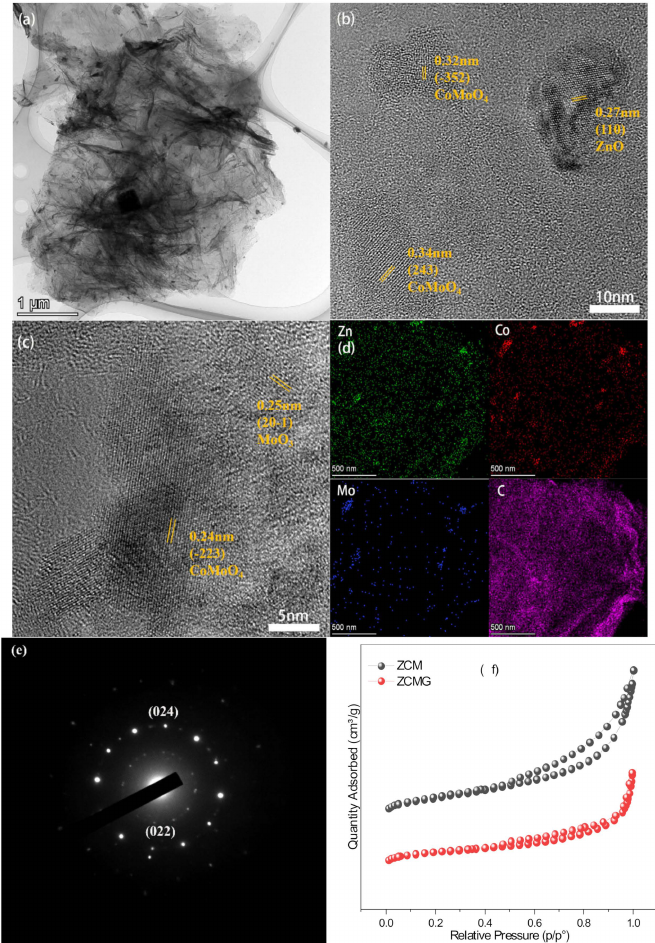
Figure 5. ( a – c ) TEM images of ZCMG. ( d ) EDS mapping of ZCMG for elements Zn, Co, Mo and C.